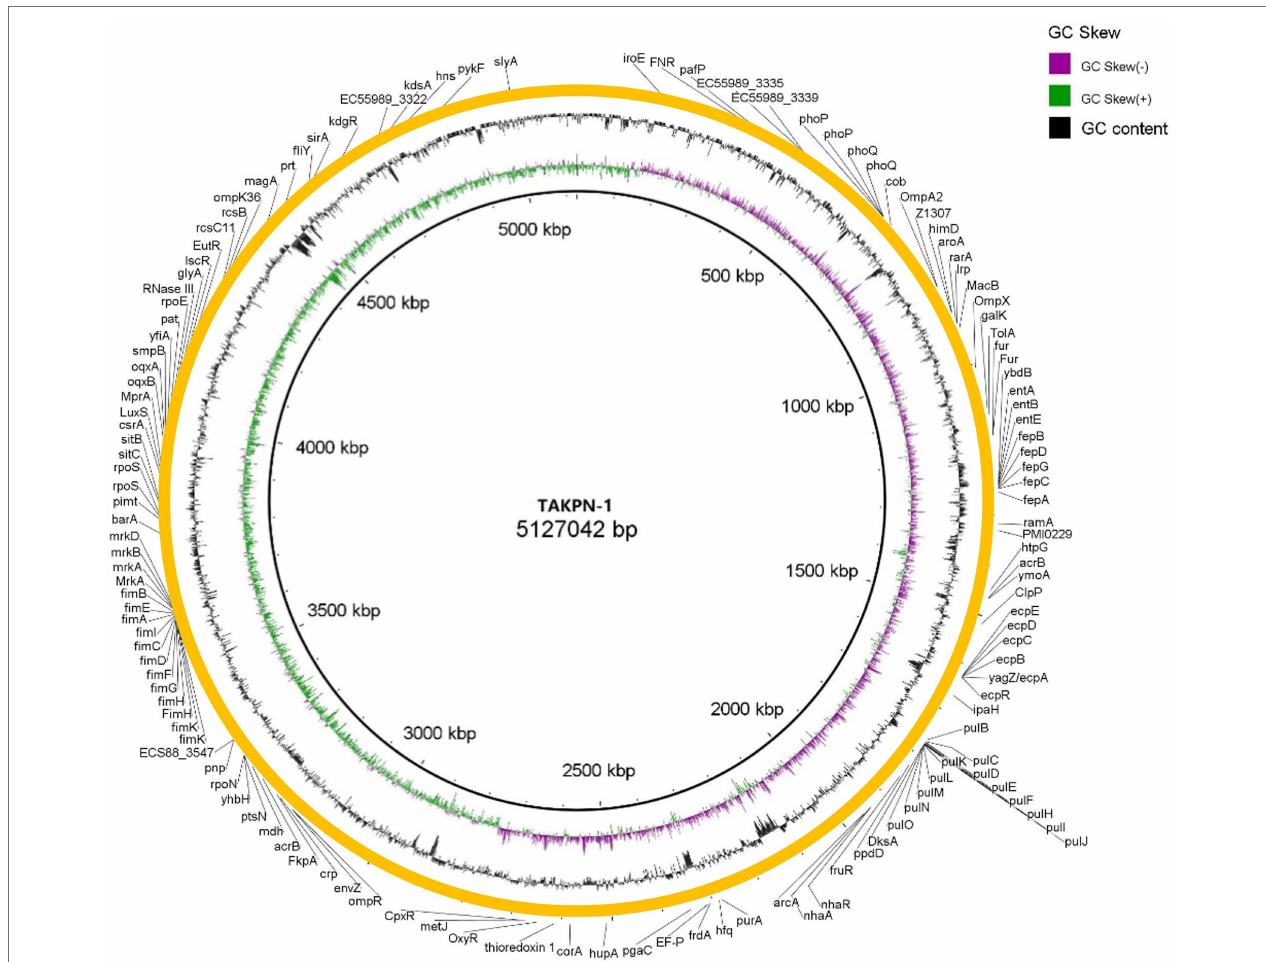
FIGURE 5 | The genome of isolate TAKPN-1. Bacterial virulence factors and pathogen host interaction (PHI) factors with identity ≥ 80% were depicted. The identity represents the sequence similarity between the genes of TAKPN-1 and those of the reference